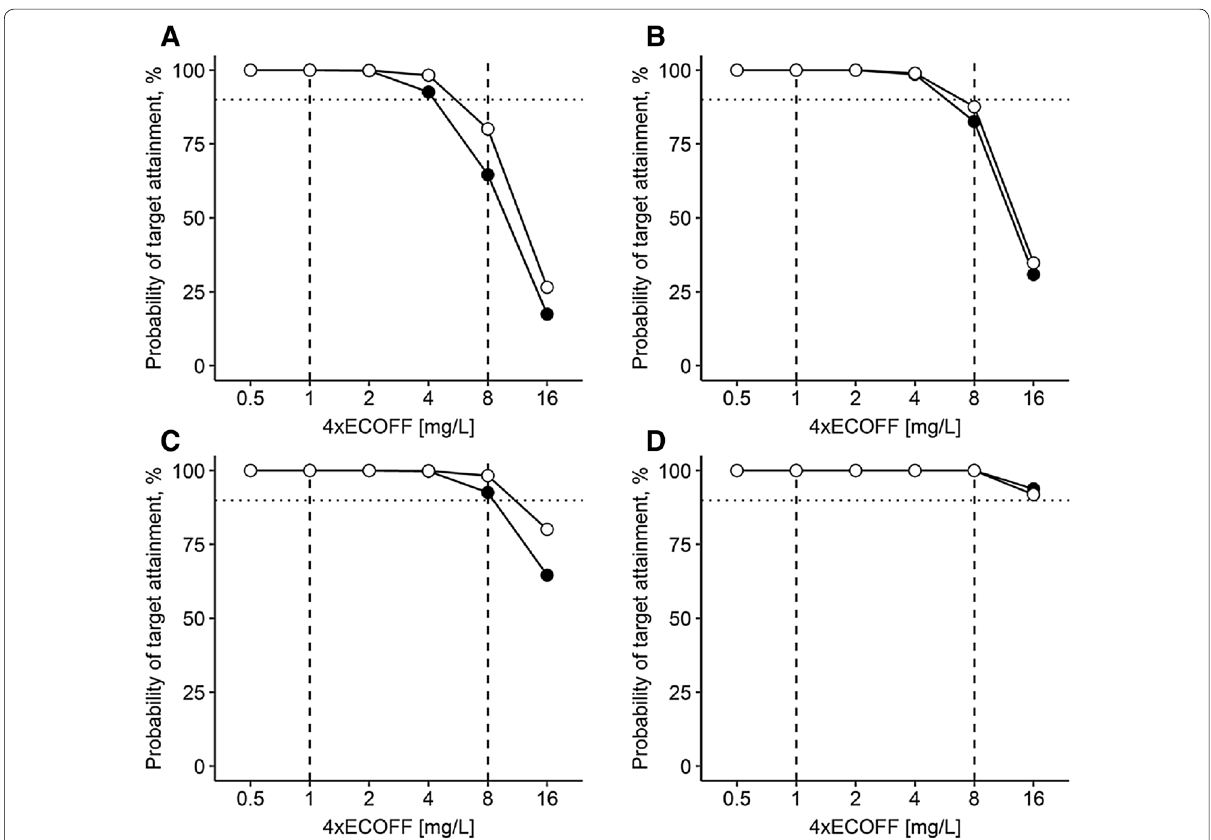
Fig. 2 Probability of target attainment at steady‑state (day 7). a 1 g quid 8 h (30 min); b 2 g loading dose (30 min) followed by 1 g prolonged infusion (over 4 h) quid 8 h; c 2 g quid 8 h (30 min); d 2 g loading dose (30 min) followed by continuous infusion of 3 g/day. Empty dots: patients with acute‑on‑chronic liver failure, closed dots: patients without liver failure, dotted horizontal line depicts probability of target attainment 90%, ≥ dashed vertical lines depict typical target concentrations as 4x European Committee on Antimicrobial Susceptibility Testing epidemiological cut‑off values (ECOFF) for Enterobacterales (4 ECOFF 0.25 mg/L 1 mg/L) and Pseudomonas spp. (4 ECOFF 2.0 mg/L 8 mg/L). MIC: minimal inhibitory × = × =